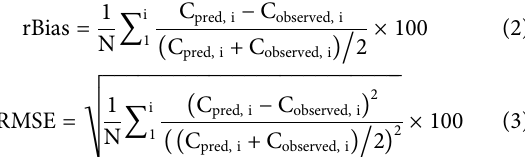
Frontiers in Pharmacology |